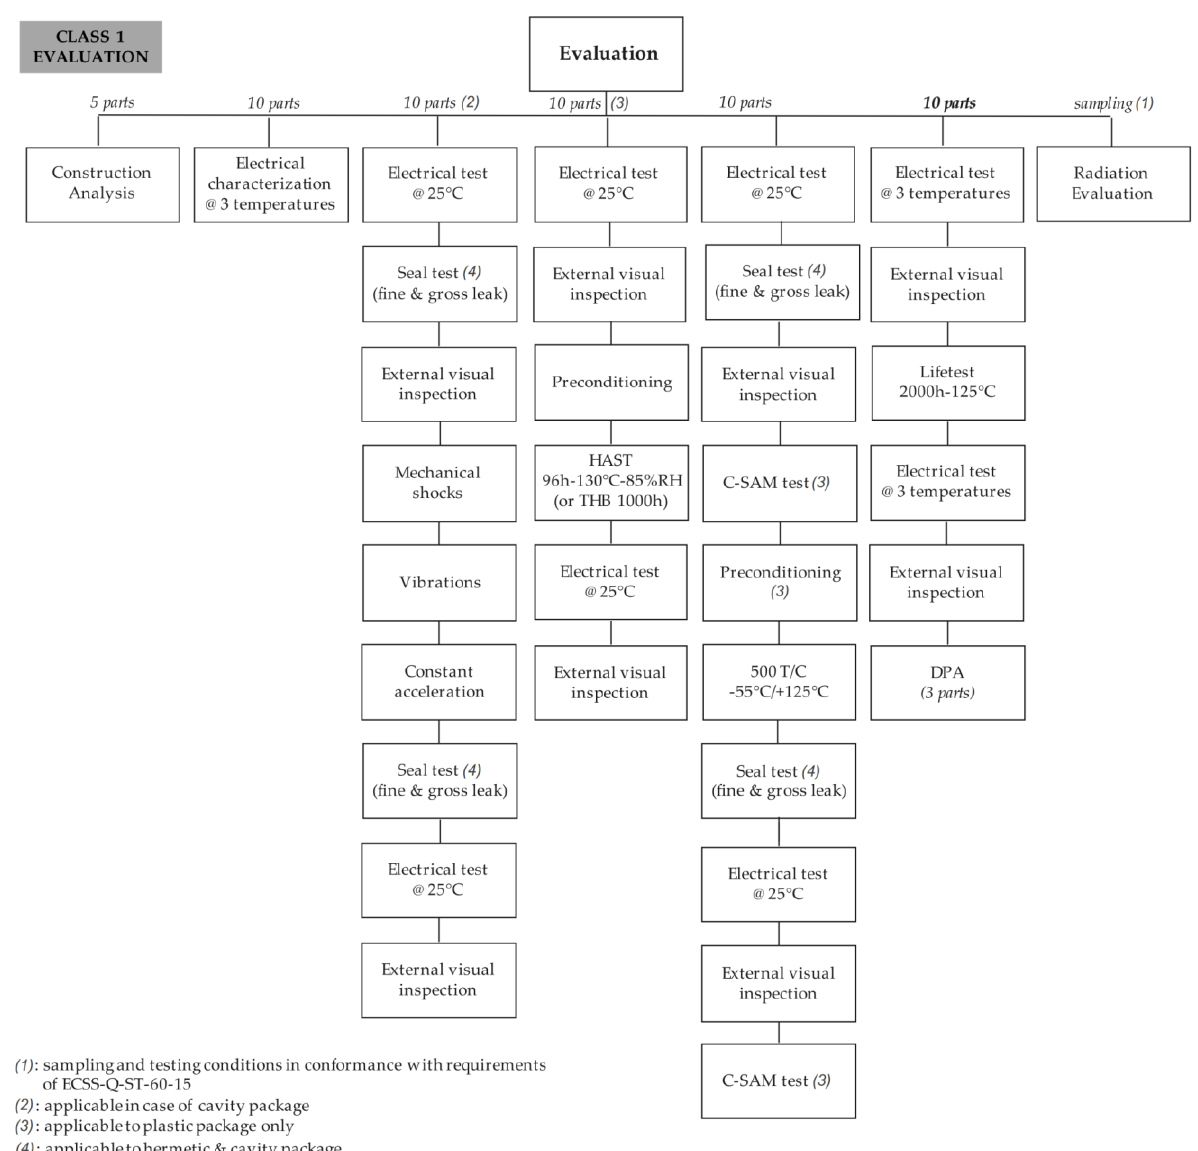
Figure 3. Evaluation tests flow chart for class-1 EEE components. Reprinted from ref. [4].